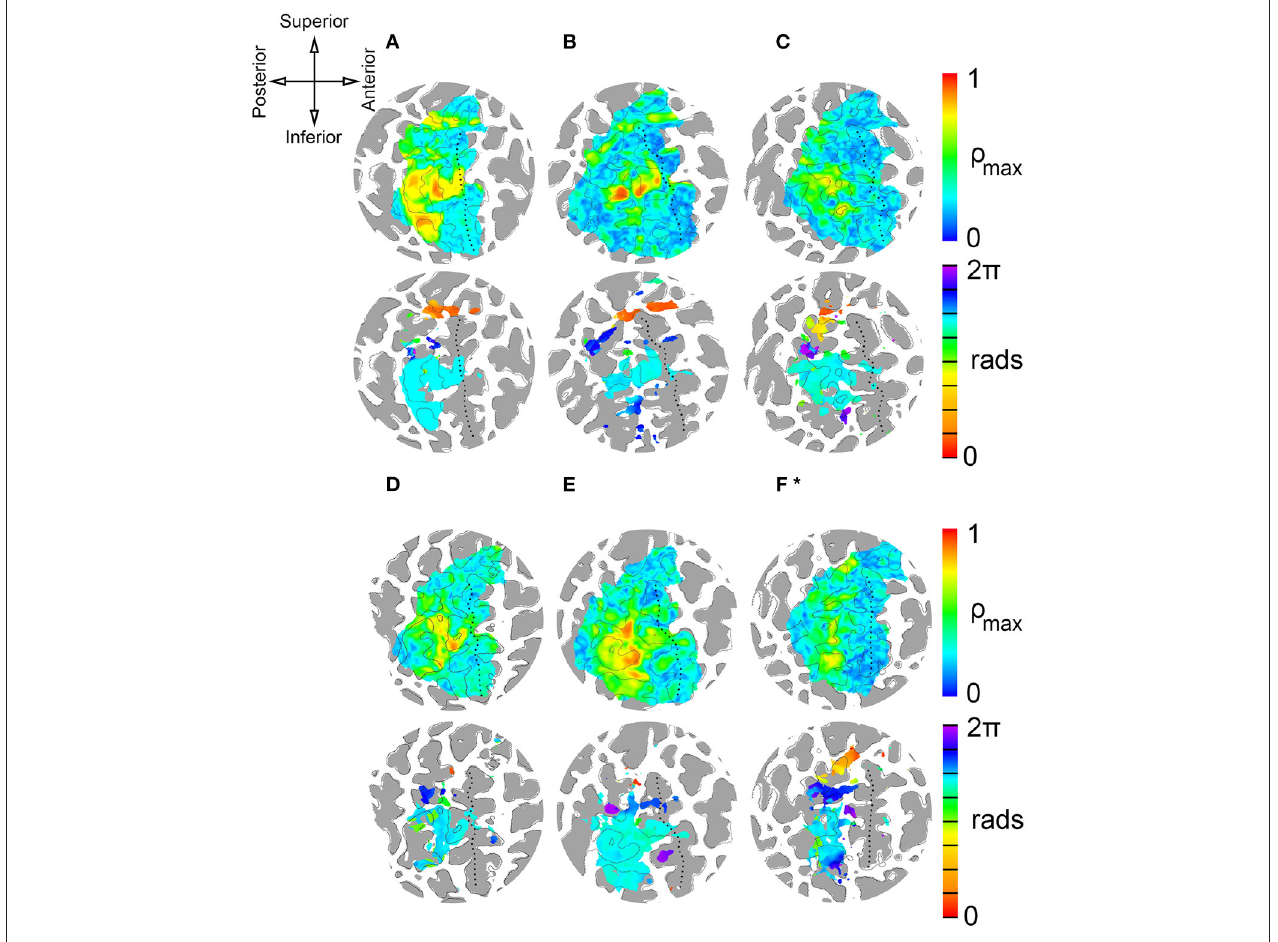
FIGURE 4 | Single-subject results from delay analysis. (A–F)* : Maximum cross-correlation coefficients ρ (top circles) and phase delays 1φ of cortical surface elements (gray areas are regions of negative convexity). Phase delays are shown for surface elements with average ρ ≥ 0.45. ROI contains central sulcus, postcentral gyrus, postcentral sulcus, and paracentral lobule. (*) Stimulation period for subject F was 40 s (8 × 5 s). Stimulation period for subjects A-E was 72 s (8 × 9 s). Top left: Anatomical orientation of flattened maps. Superior and inferior also correspond to medial and lateral,